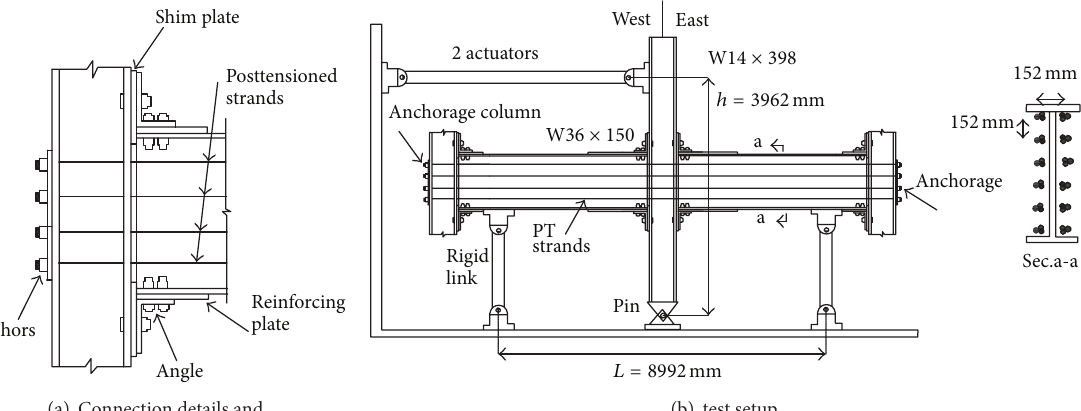
Figure 7: Garlock’s experiments [3].